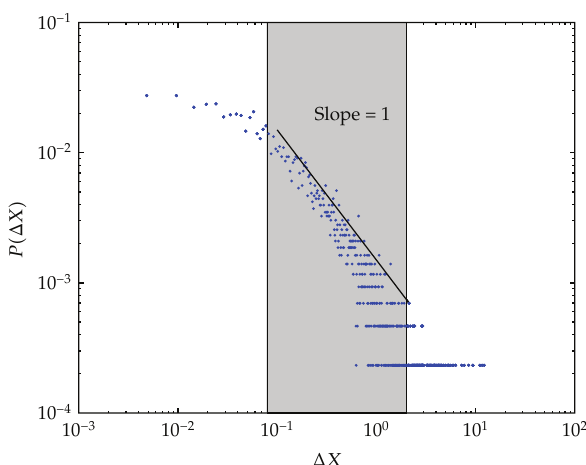
Figure 3: Probability distribution of Δ X . We adopt the method of nonlinear least square to estimate the exponent. Slope (cid:8) 1 . 07, SSE (cid:8) 1 × 10 − 4 , R -square (cid:8) 0 . 8999, and RMSE (cid:8) 7 . 9 × 10 − 4